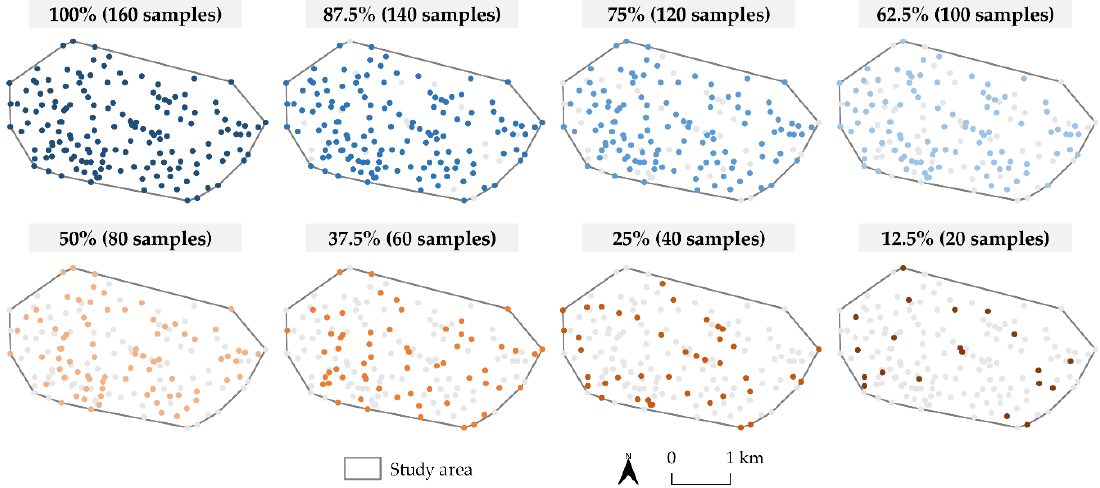
Figure 3. The display of soil samples contained in eight soil subsets.